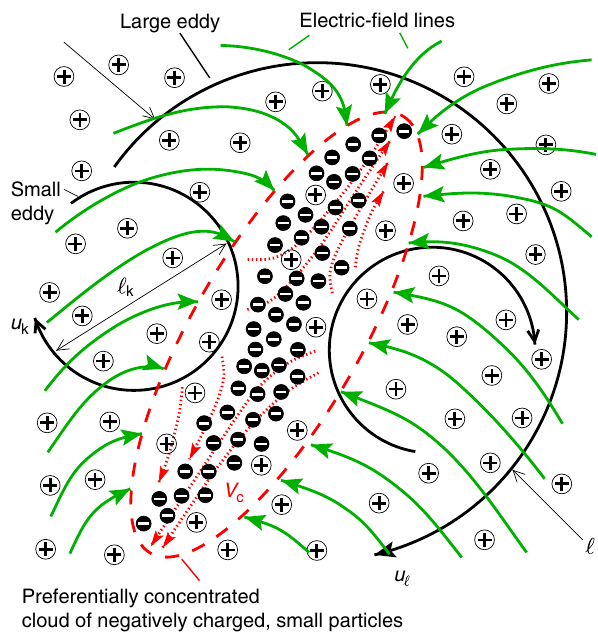
Fig. 1 Aerodynamic generation of electric fi elds by turbulence. The turbulence preferentially concentrates negatively charged small particles in interstitial regions between vortices, where the strain rate is large (schematics, not to scale). Conversely, the larger, positively charged particles are comparatively more ballistic, and as a result they are more uniformly distributed than the smaller, negatively charged particles. The large imbalance of charge created within the cloud leads to incoming